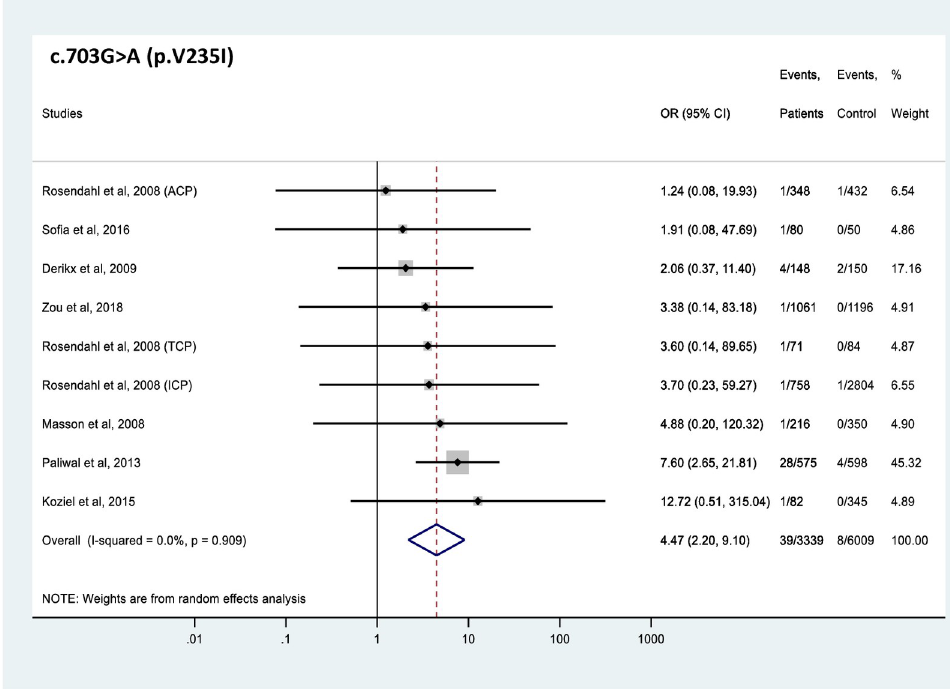
Fig 3. Forest plot showing odds ratios for pancreatitis risk in patients carrying the c.703G > A (p.V235I) CTRC variant. OR, odds ratio; CI, confidence interval.